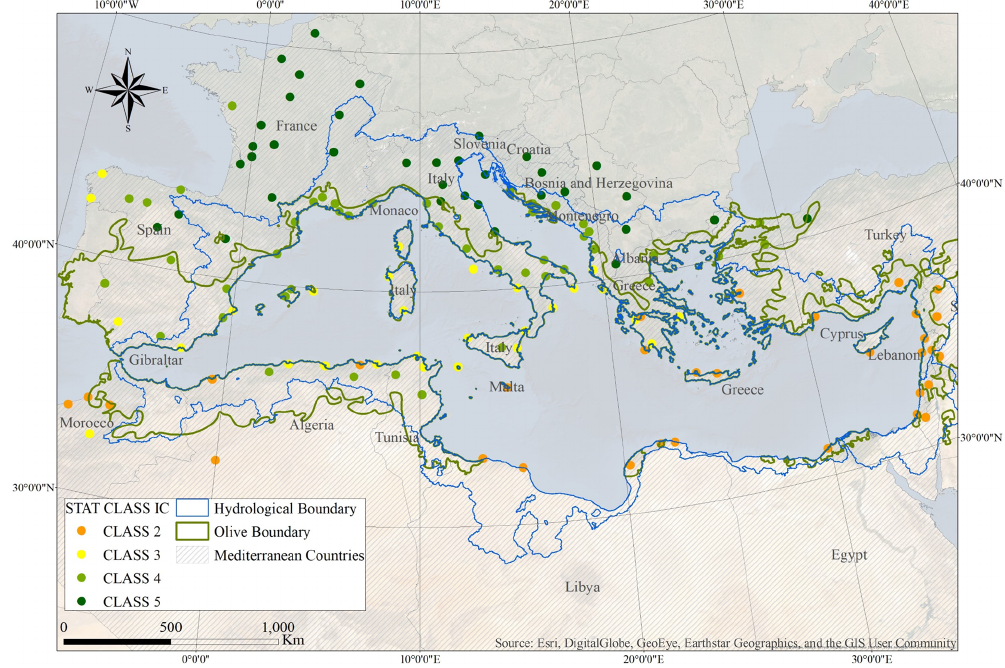
Figure 5. Geographical distribution of the Mediterranean climatic classes based on 144 stations’ climatic indices.